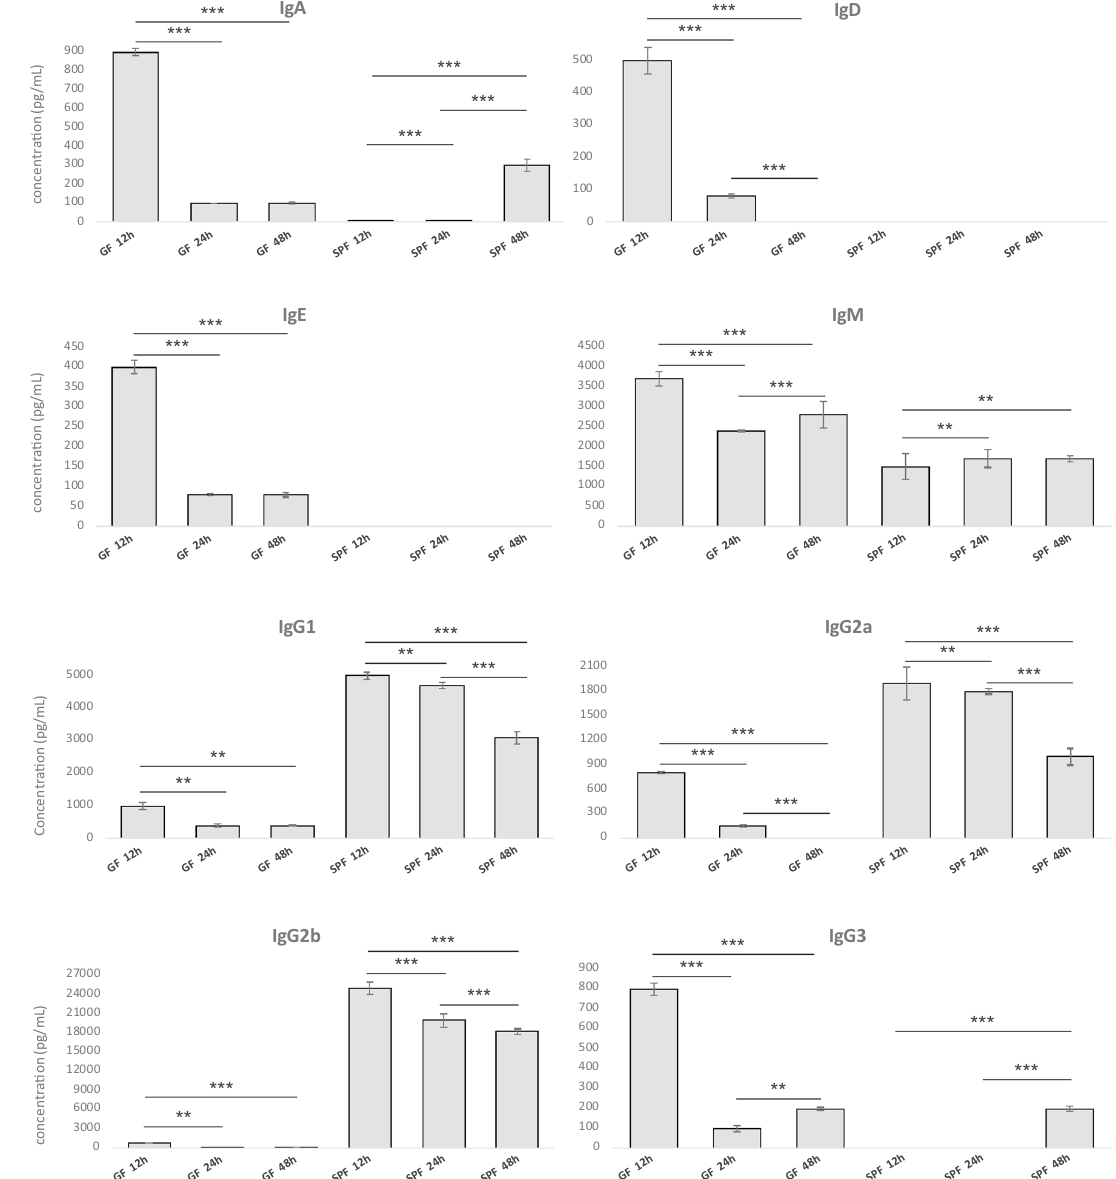
Figure 1. Isotypes of early infection-induced antibodies and their kinetics in Balb/c GF mice sera and Balb/c SPF mice sera obtained 12, 24, and 48 h after F. tularensis FSC200 intraperitoneal infection, dose of 10 2 CFU in total volume of 0.2 mL of saline. The immunoglobulin subclasses of serum samples were determined using a Quantibody mouse immunoglobulin isotype array while following the manufacturer’s instructions. The antibody isotypes compositions of Balb/c SPF and GF murine sera obtained from naïve mice without any bacterial colonization were very low and are not shown in these graphs. The basal individual antibody isotypes levels for GF mice were significantly lower in comparison with the corresponding isotypes levels for SPF mice (data not shown). The Quantibody mouse immunoglobulin isotype arrays were performed in biological triplicates (individual sera) for all time intervals and were independently repeated at least three times. Reference isotypes are presented. Values are expressed as mean ± standard deviation (SD) and analyzed for significance using Student’s two-tailed t -test. Differences were considered statistically significant at **p < 0.01 and *p < 0.05 and are denoted by being a different spectrum of IgM antibody clones (specificities) that reacted with different Francisella proteins (Supplementary Fig. S3). Molecular targets of the early produced antibodies. Francisella tularensis subs. holarctica FSC200 whole-cell lysate was separated by 2-DE using broad range IPG strips of pH 3–10. To validate reproducibility of the separation technique, two independent whole-cell lysates were prepared. Reference silver-stained gel was